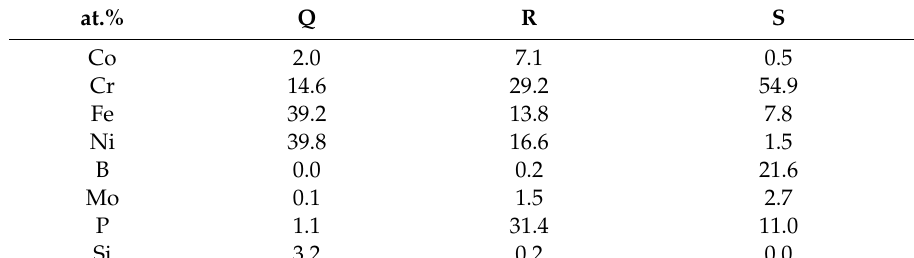
Table 5. The EPMA quantitative chemical analyses in Figure 7.